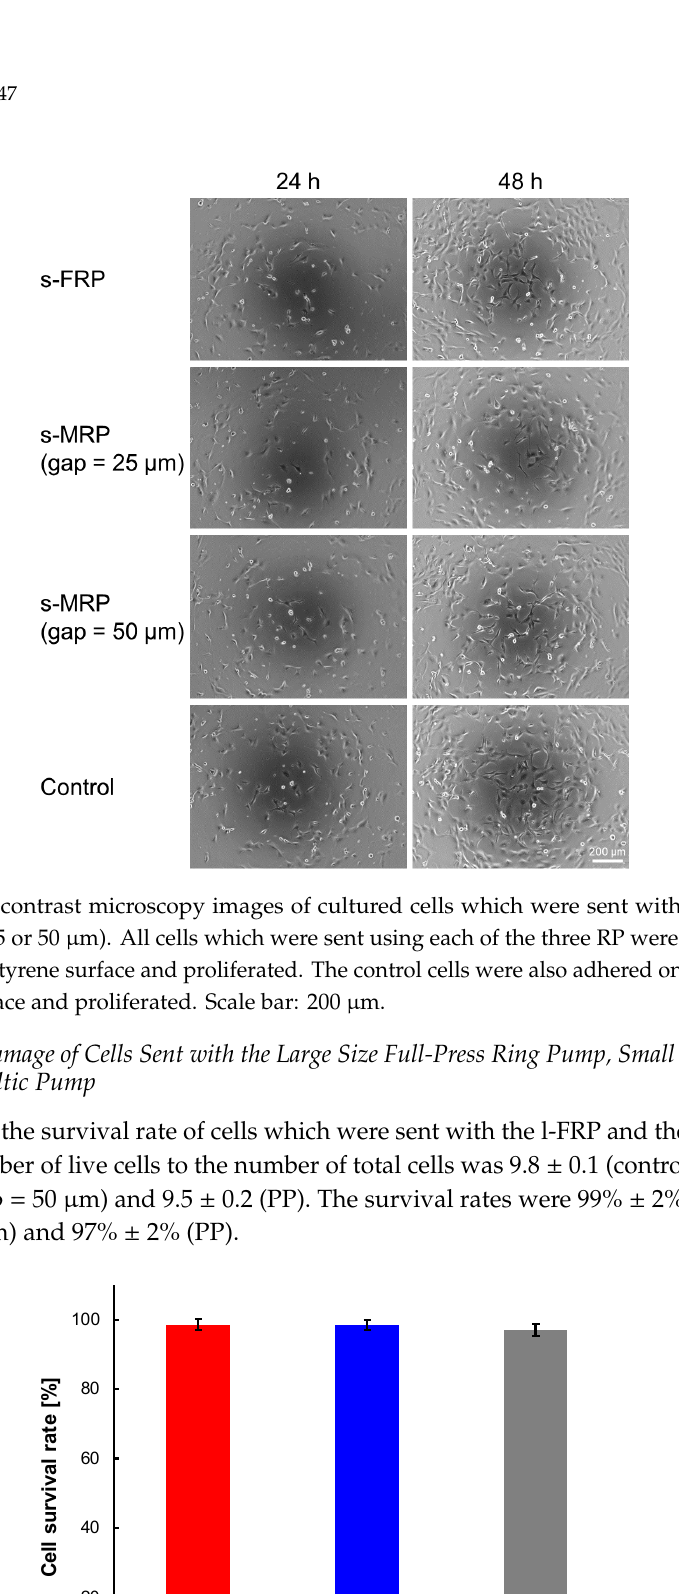
Figure 5. Survival rate of cells which were sent with the s-FRP and two s-MRPs. The survival rates